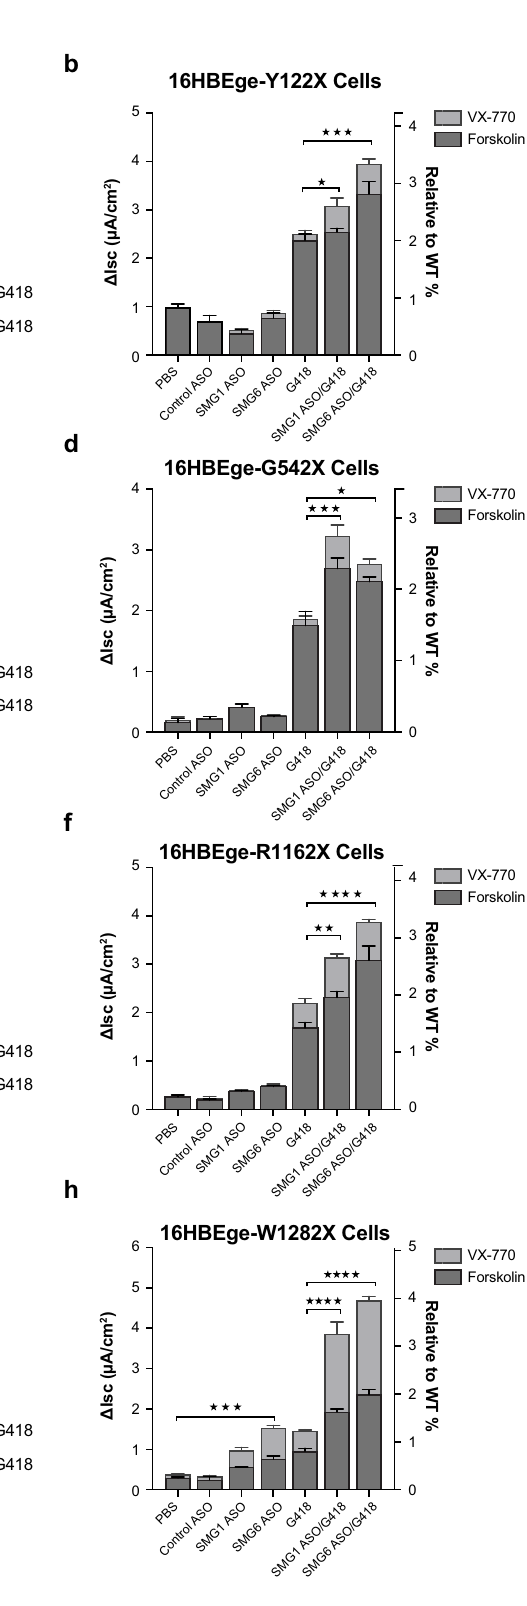
pathway independent of UPF2, UPF3 paralogs, and EJC factor investigation using primary patient cells containing the CFTR eIF4A3. One advantage of the CFF-16HBEge cell model system Y122X nonsense mutation is required. used in this study is that the CFTR Y122X nonsense mutation After nonsense codon recognition and tagging by SMG1- exists within the native genomic context, which could more mediated phosphorylation of UPF1, destruction of NMD sub- closely re fl ect the endogenous situation. However, further strates can occur through endonucleolytic cleavage by SMG6 or NATURE COMMUNICATIONS| (2022) 13:2344